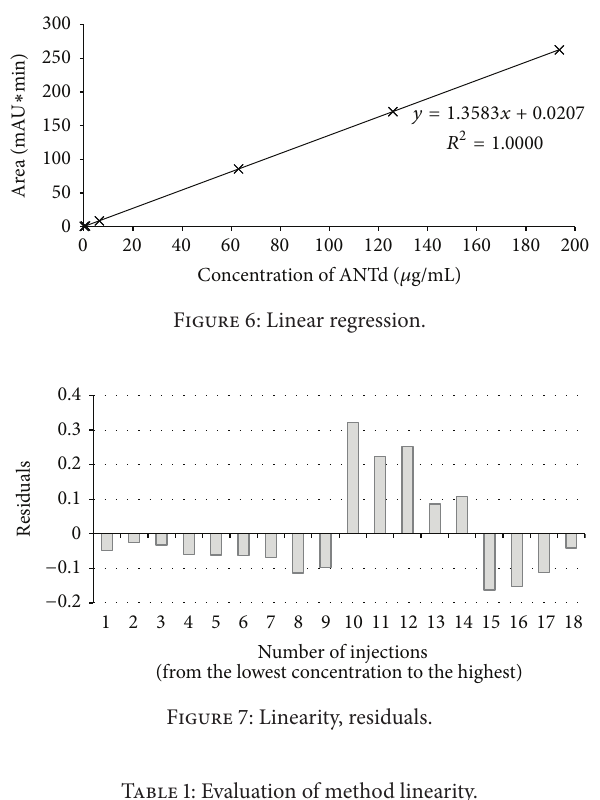
Figure 7: Linearity, residuals. Table 1: Evaluation of method linearity.